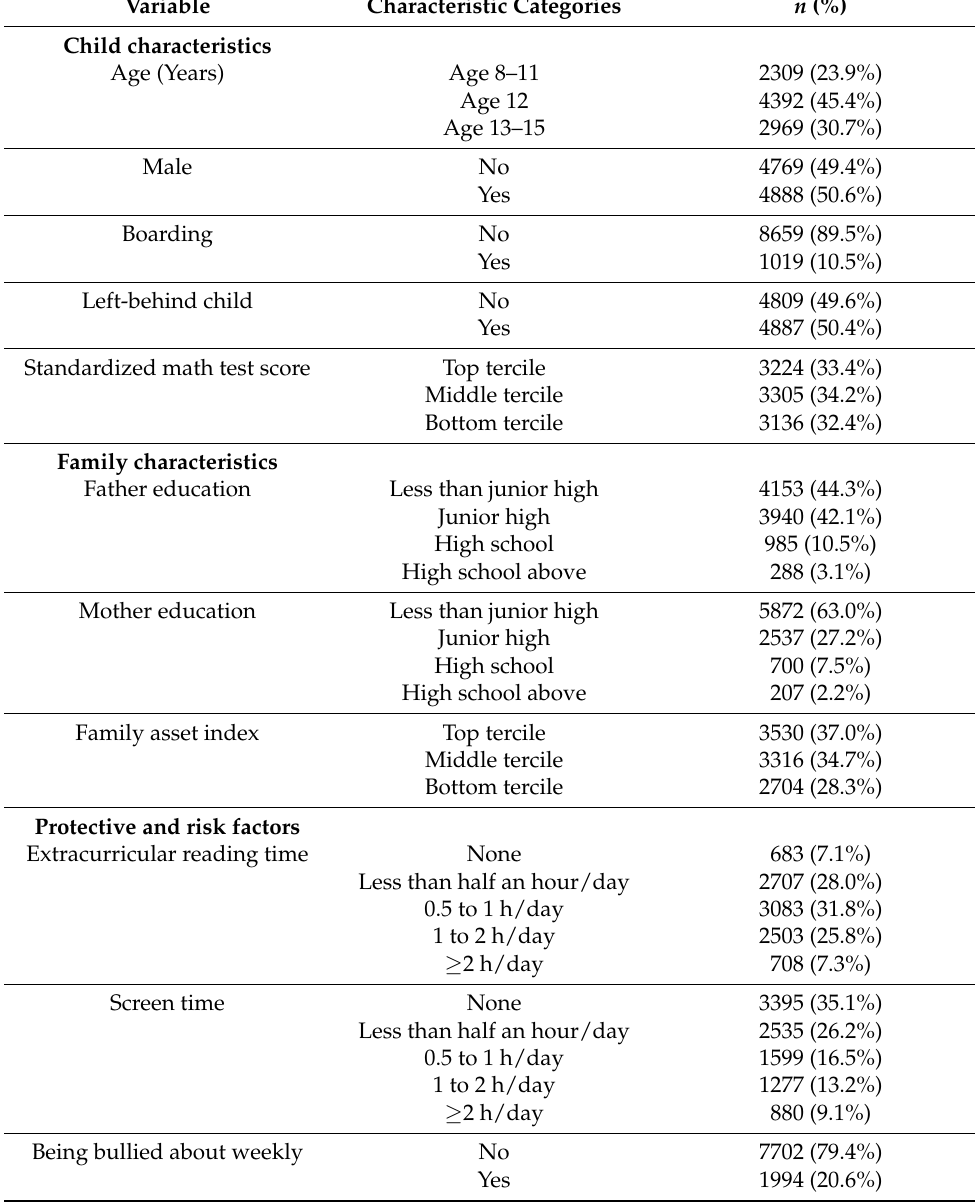
Table 1. Summary of child and family